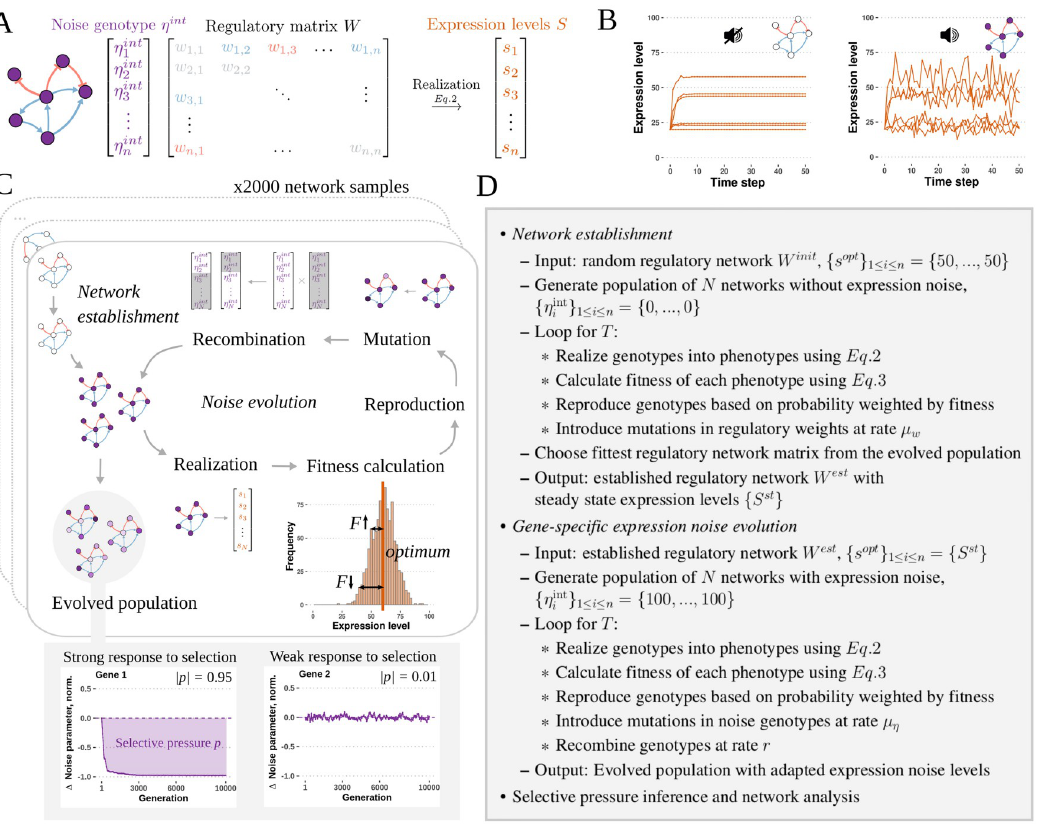
Fig 1. The evolution of gene-specific expression noise was simulated using populations of model gene regulatory networks with mutable levels of gene-specific expression noise under selective and non-selective conditions. A —Gene regulatory network model. The genotype consists of the intrinsic noise vector η int and regulatory matrix W . The intrinsic noise vector defines the gene- specific expression variance of each gene in the network. The regulatory matrix defines the regulatory interactions in the network. The genotype is realized into the phenotype using the dynamical equation described in the main text. The phenotype is given by the state vector S , which represents the expression level of each gene in the network. B —Deterministic (left) and stochastic (right) realizations of the model. C —Steps of the evolutionary simulation process. Each established network configuration was used as a founding network for the network populations used in the noise evolution simulation. In every generation, genotypes are realized and phenotypes (expression levels) are sampled from the last time step. Fitness is calculated from the expression levels. If the populations are evolved under selection, fitness is calculated as the distance of the expression level of each gene from the optimal expression level. Genotypes are reproduced based on their relative fitness and mutations in the intrinsic noise vectors are introduced. Noise genotype vectors are recombined by randomly choosing individuals for recombination and shuffling their noise vectors. The process is repeated for 10,000 generations. D —Algorithm